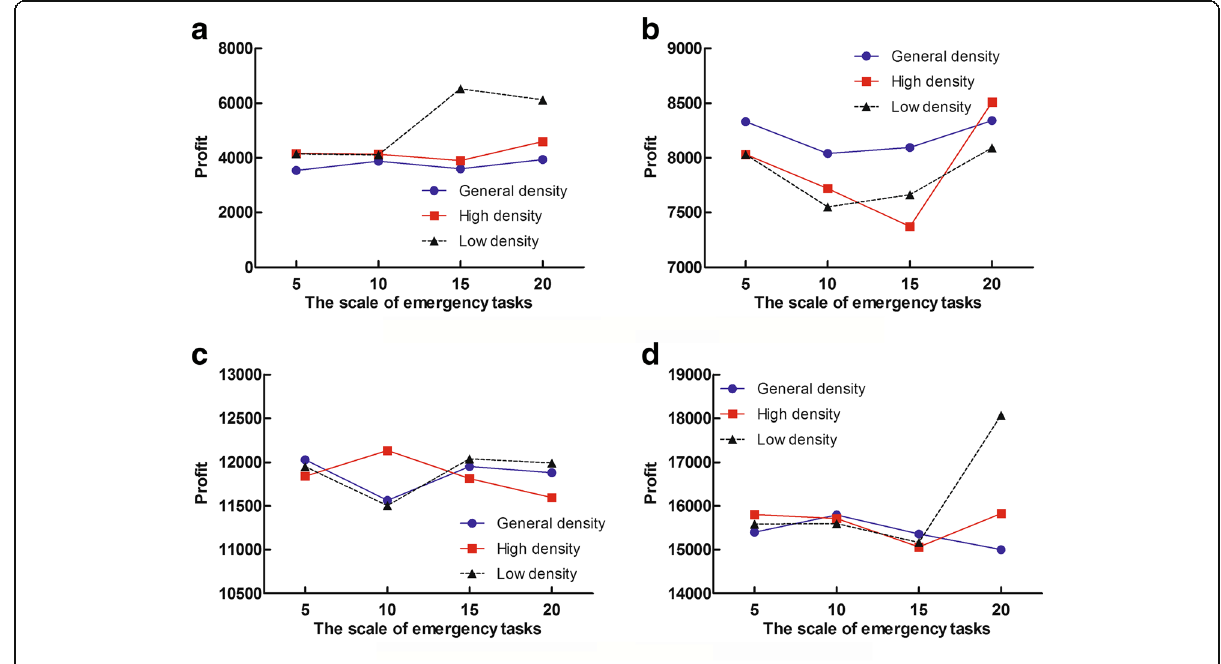
Fig. 5 The profit of GETIA ( a , b , c , d